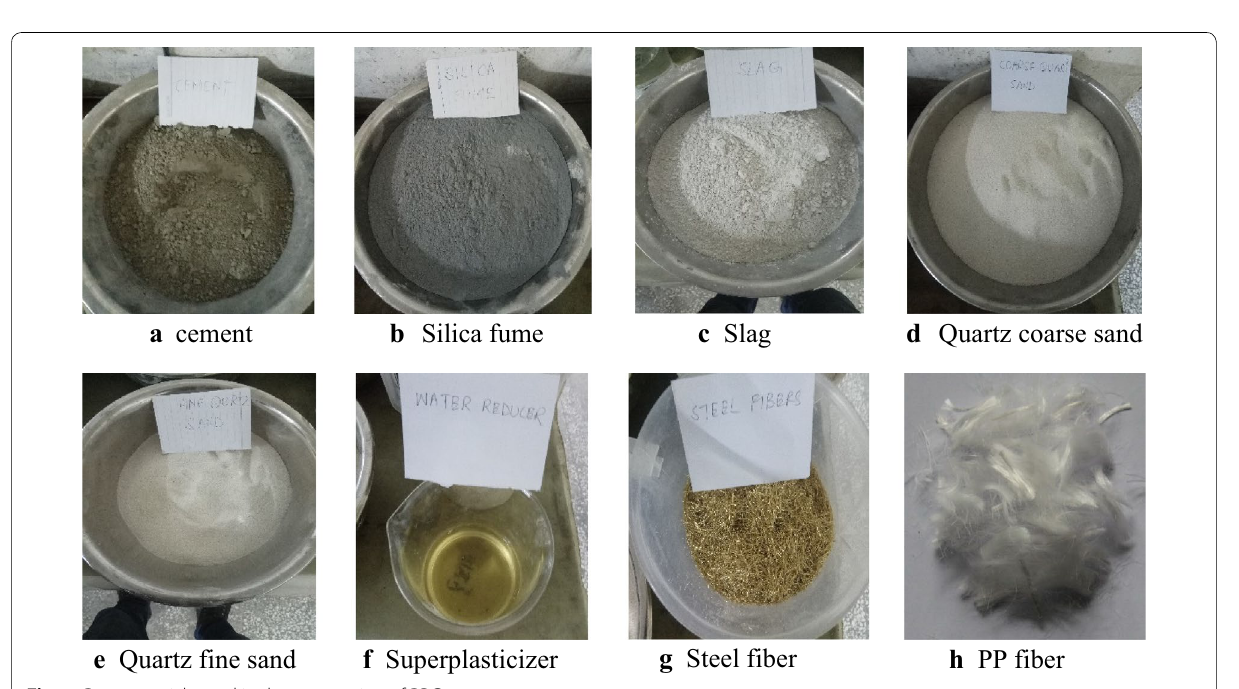
Fig. 1 Raw materials used in the preparation of RPC.